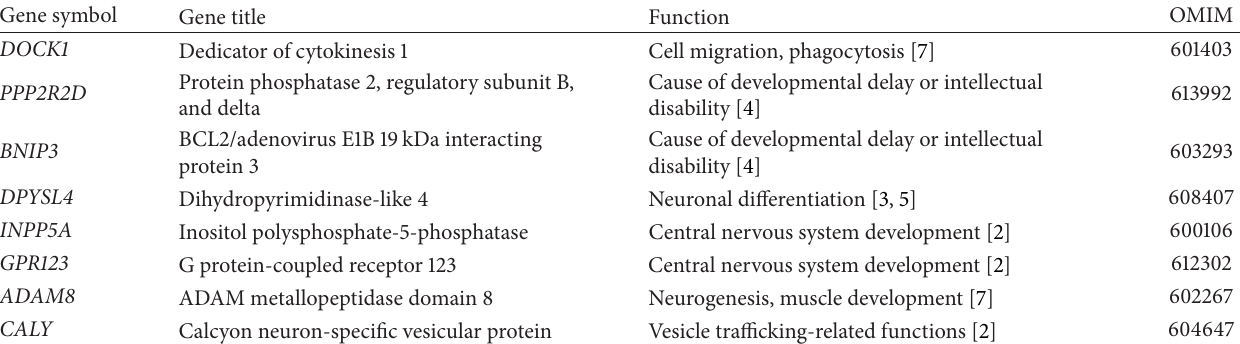
Table 1: OMIM genes located in the deleted 10q26.2q26.3